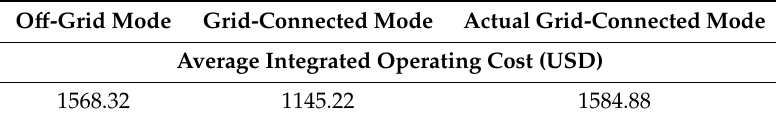
Table 3. Average integrated operating cost in di ff erent modes.